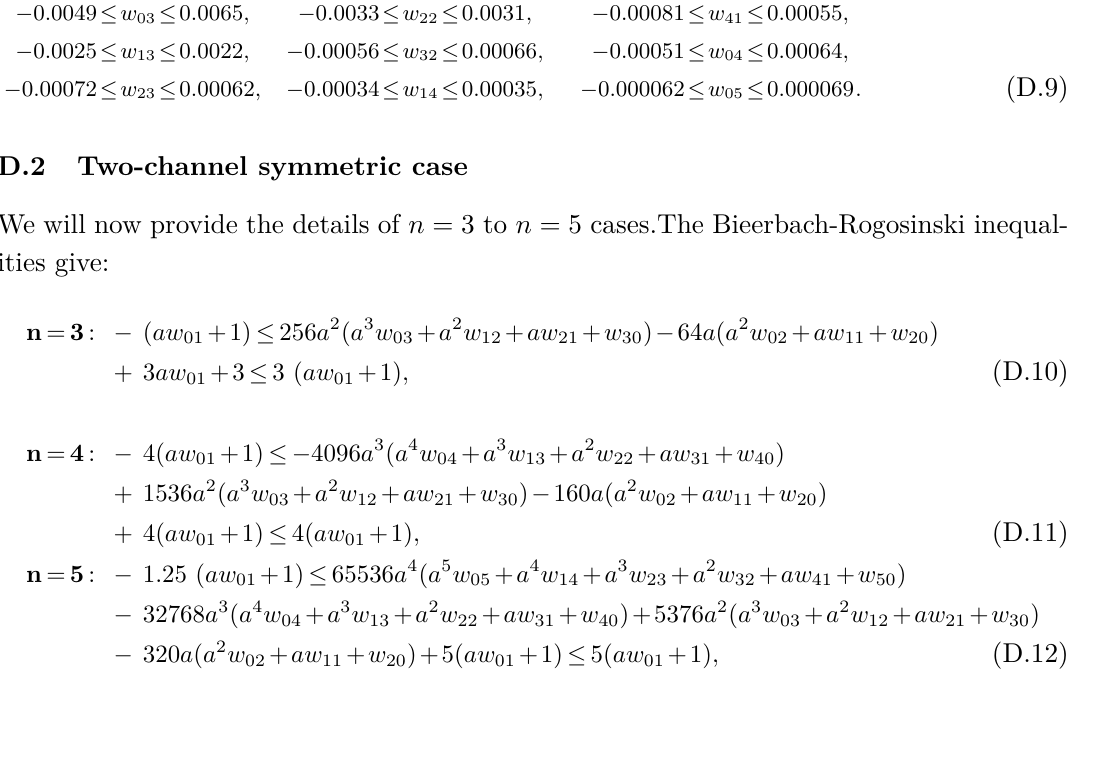
JHEP12(2021)203